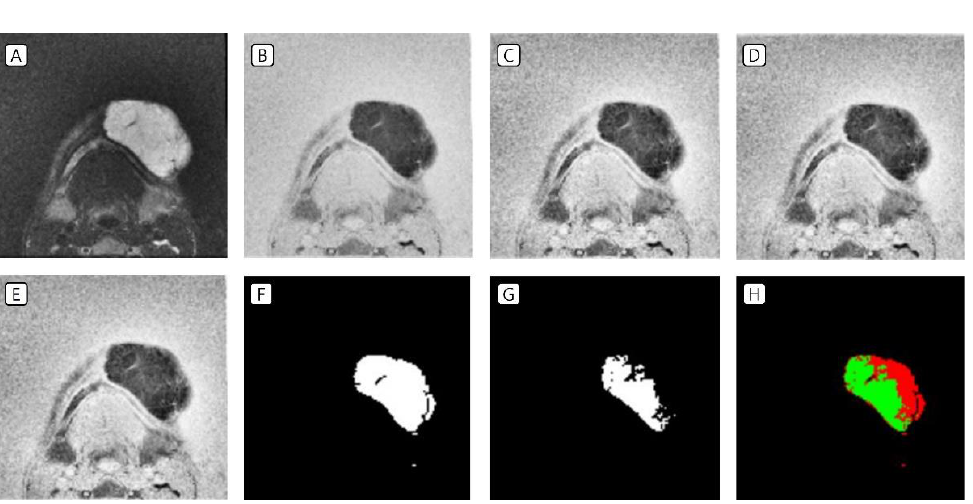
Figure 4. Test set of VMs in the left mandibular area. ( A ) Resized to a volume of 16, a height of 128, and a width of 128 pixels; ( B ) inverted image; ( C ) CLAHE application; ( D ) Z-score standardization; ( E ) minimum – maximum normalization; ( F ) labeling data drawn by the clinicians; ( G ) prediction data drawn by the artificial intelligence tool; and ( H ) green indicates the matched area, while red indicates the mismatched area. VMs, venous malformations; CLAHE, contrast-limited adaptive his- togram equalization.